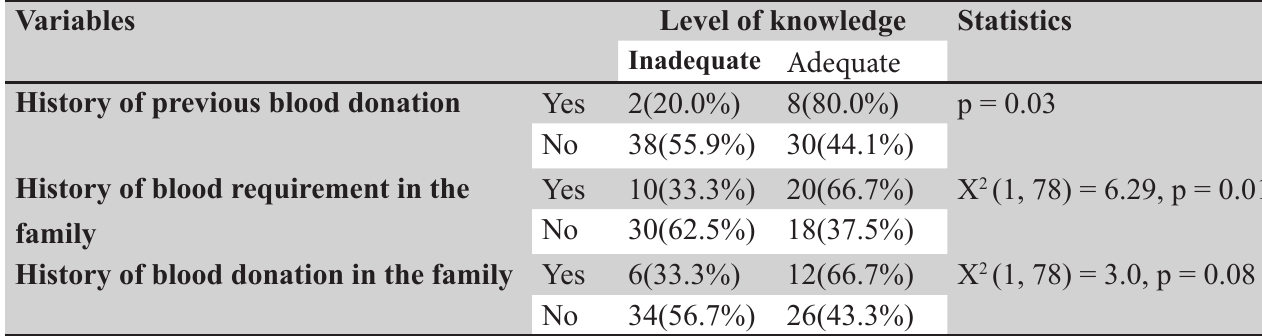
Table 3. Association between level of knowledge and history of blood donation, history of blood requirement and blood transfusion in the family